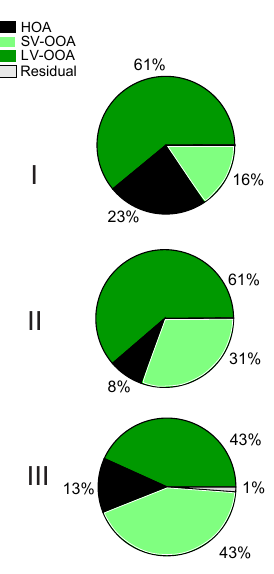
Fig. 7. Mass fraction of total organic accounted for by each PMF factor during regimes I, II, and III.